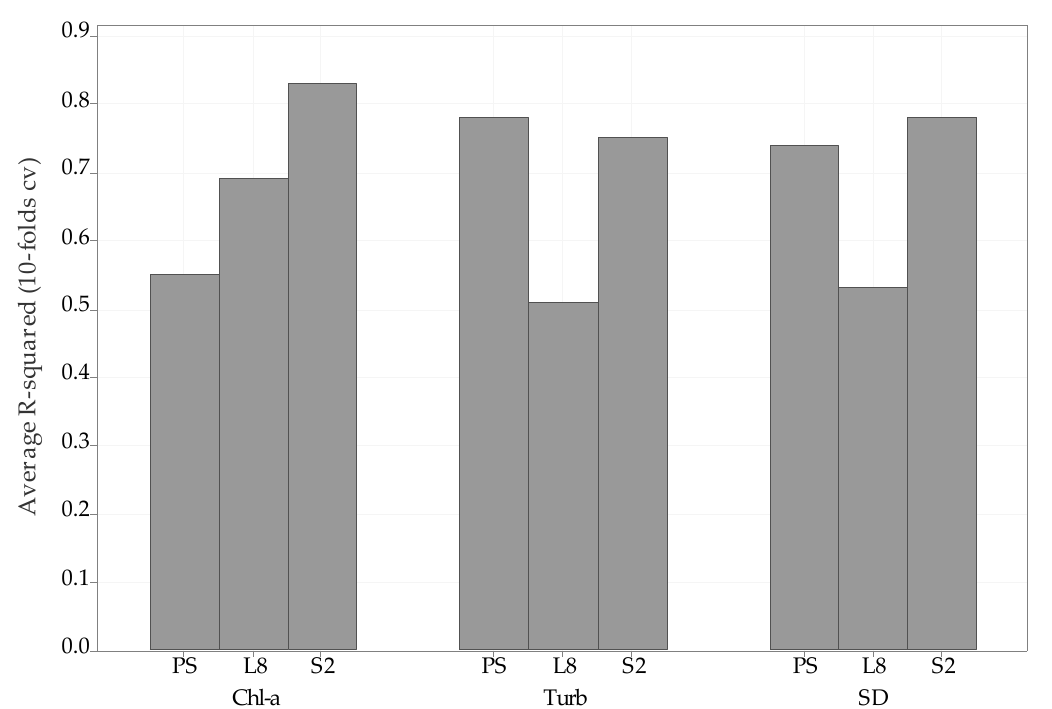
Figure 5. Average R 2 values in the 10-fold cv of the parameters with PS, Landsat-8, and Sentinel-2.